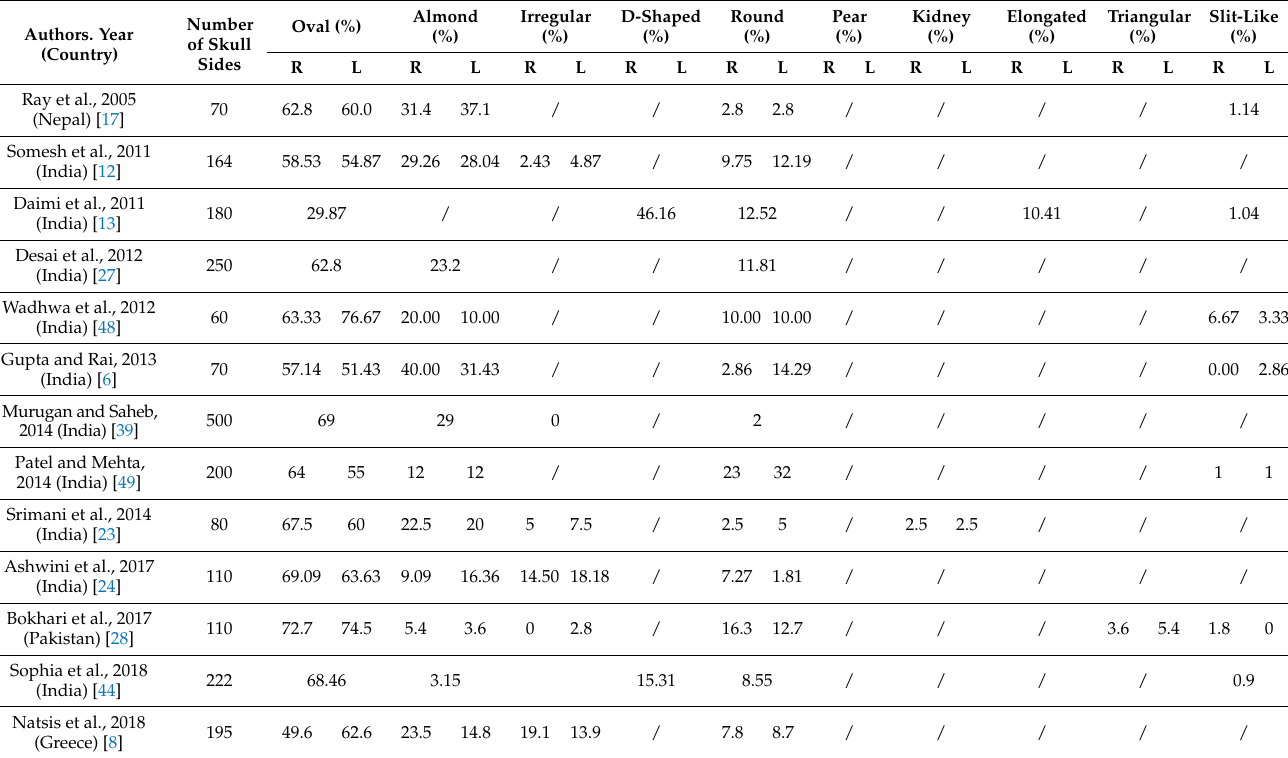
Table 4. Comparison of FO shapes between the present and previous